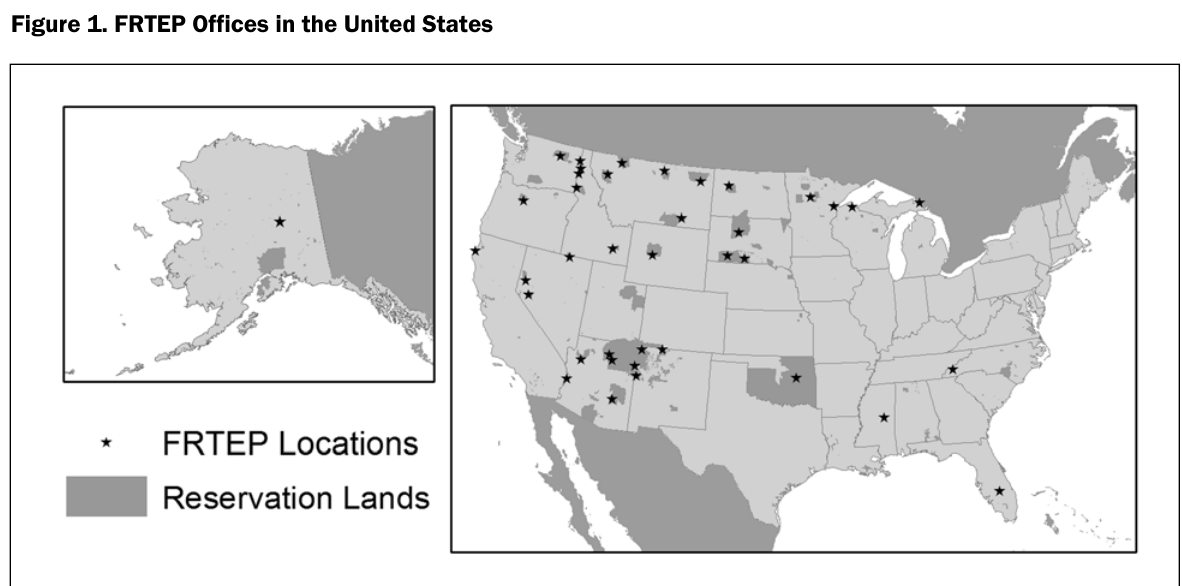
Figure 1. FRTEP Offices in the United